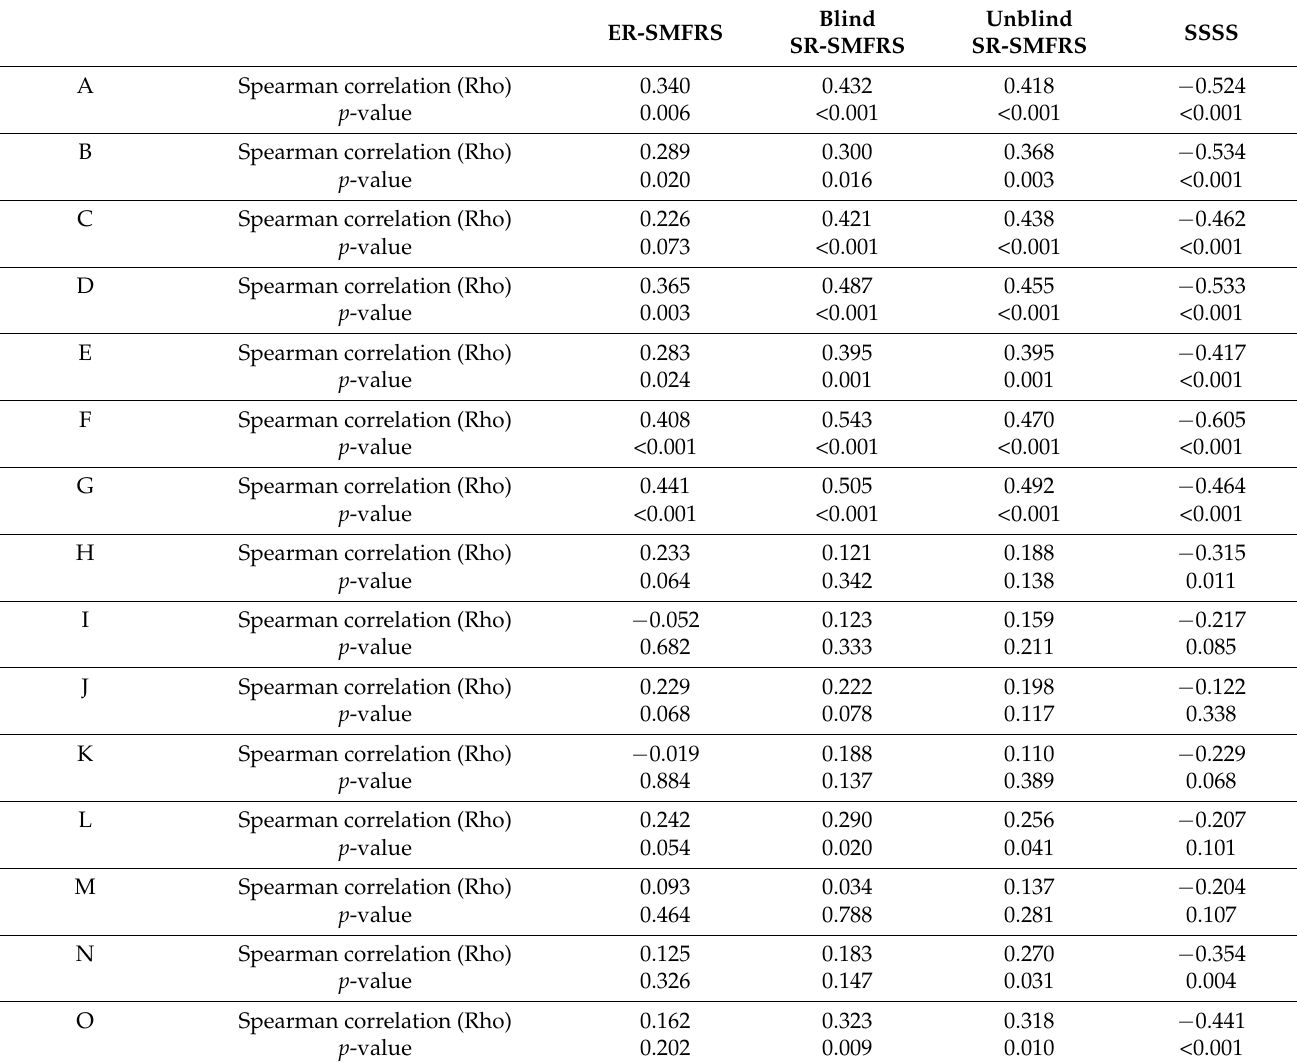
Table 9. Correlation of DAS24 with ER-SMFRS, blind SR-SMFRS, unblind SR-SMFRS, and